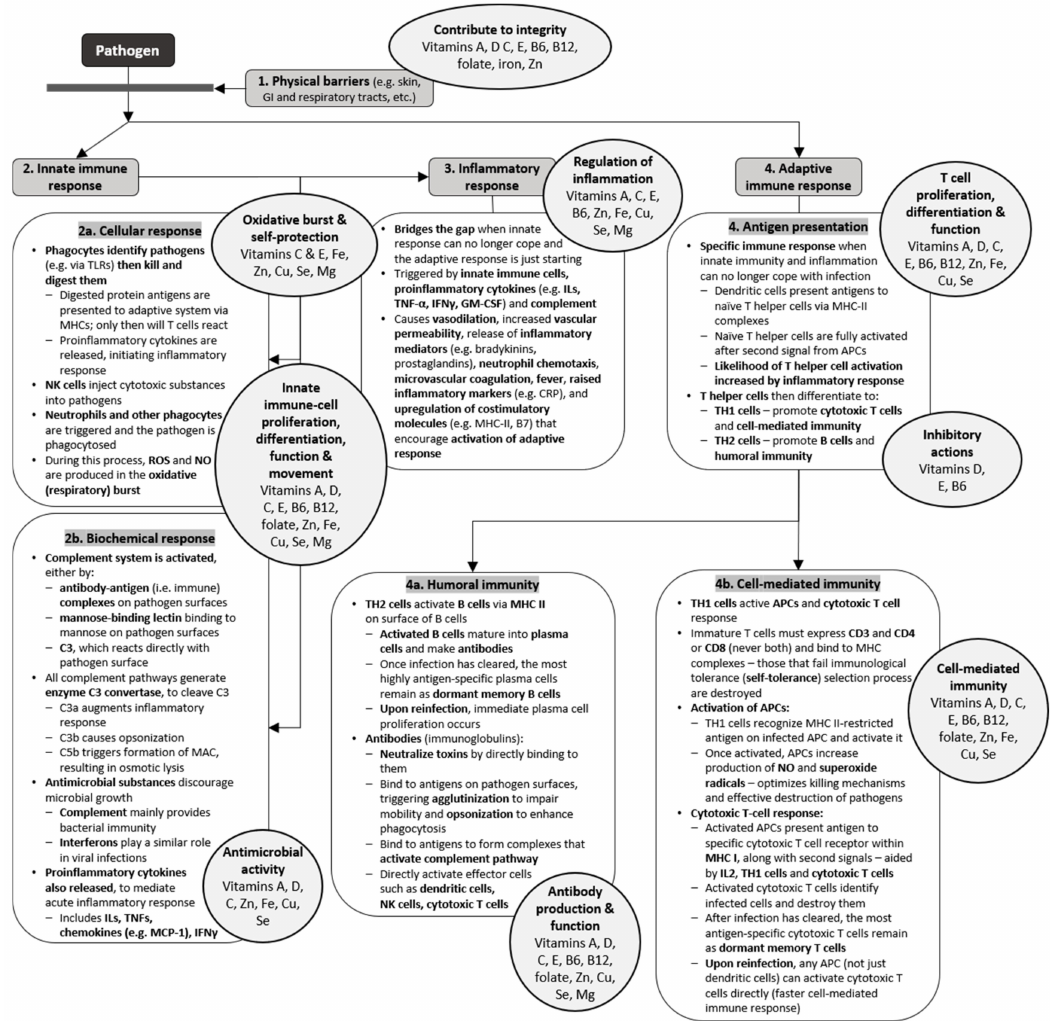
Figure 2. Micronutrients have key roles at every stage of the immune response [2,7–9]. This schematic summarizes important components and processes that are involved in di ff erent aspects of the innate and adaptive immune responses. The circles highlight those micronutrients that are known to a ff ect these responses. The significant overlap between micronutrients and processes indicates the importance of multiple micronutrients in supporting proper function of the immune system. Abbreviations: APCs, antigen-presenting cells; C3, complement component 3; CRP, C-reactive protein; Cu, copper; Fe, iron; IFNs, interferons; Igs, immunoglobulins; ILs, interleukins; GI, gastrointestinal; GM-CSF, granulocyte-macrophage colony stimulating factor; MAC, membrane attack complex; MCP-1, monocyte chemoattractant protein-1; Mg, magnesium; MHCs, major histocompatibility complexes; NK, natural killer; NO, nitric oxide; ROS, reactive oxygen species; Se, selenium; TLRs, toll-like receptors; TNF, tumor-necrosis factors; Zn,